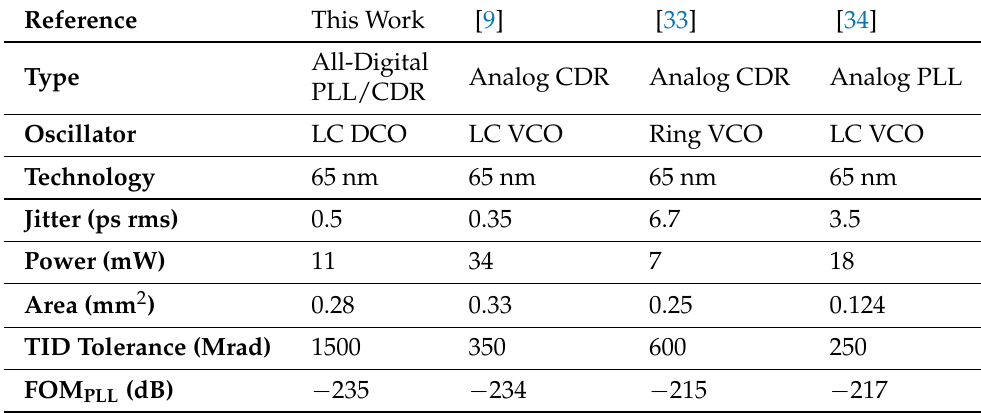
Table 1. Comparison of radiation tolerant PLL/CDR